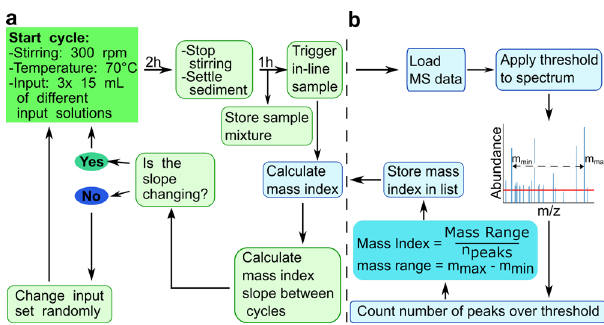
Fig. 3 Schematic work fl ow of the automated system. a The general tasks. b The decision-making process of the algorithm. The formula for the Mass Index was previously reported by Doran et al. 20